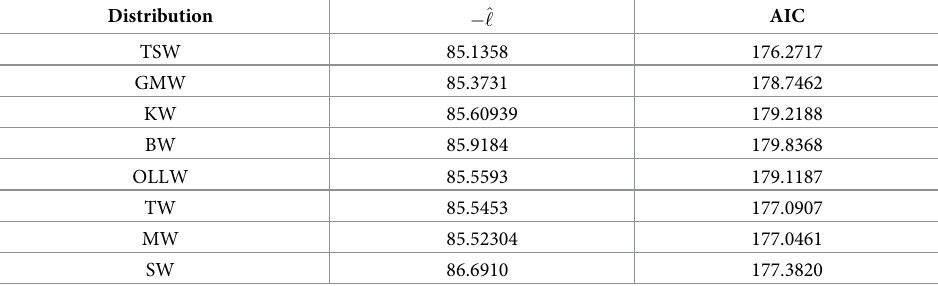
Table 5. The (cid:0) ^ ‘ and AIC for the second data set.